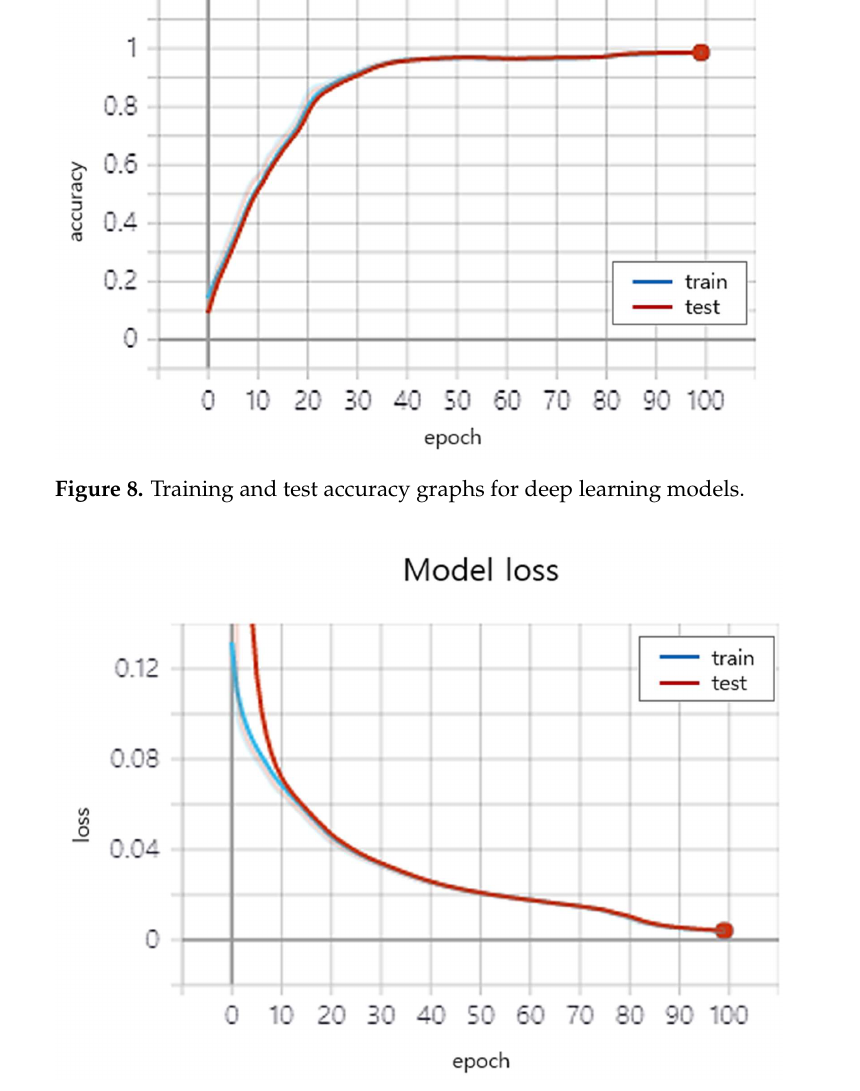
Figure 9. Training and test loss graphs for deep learning models.